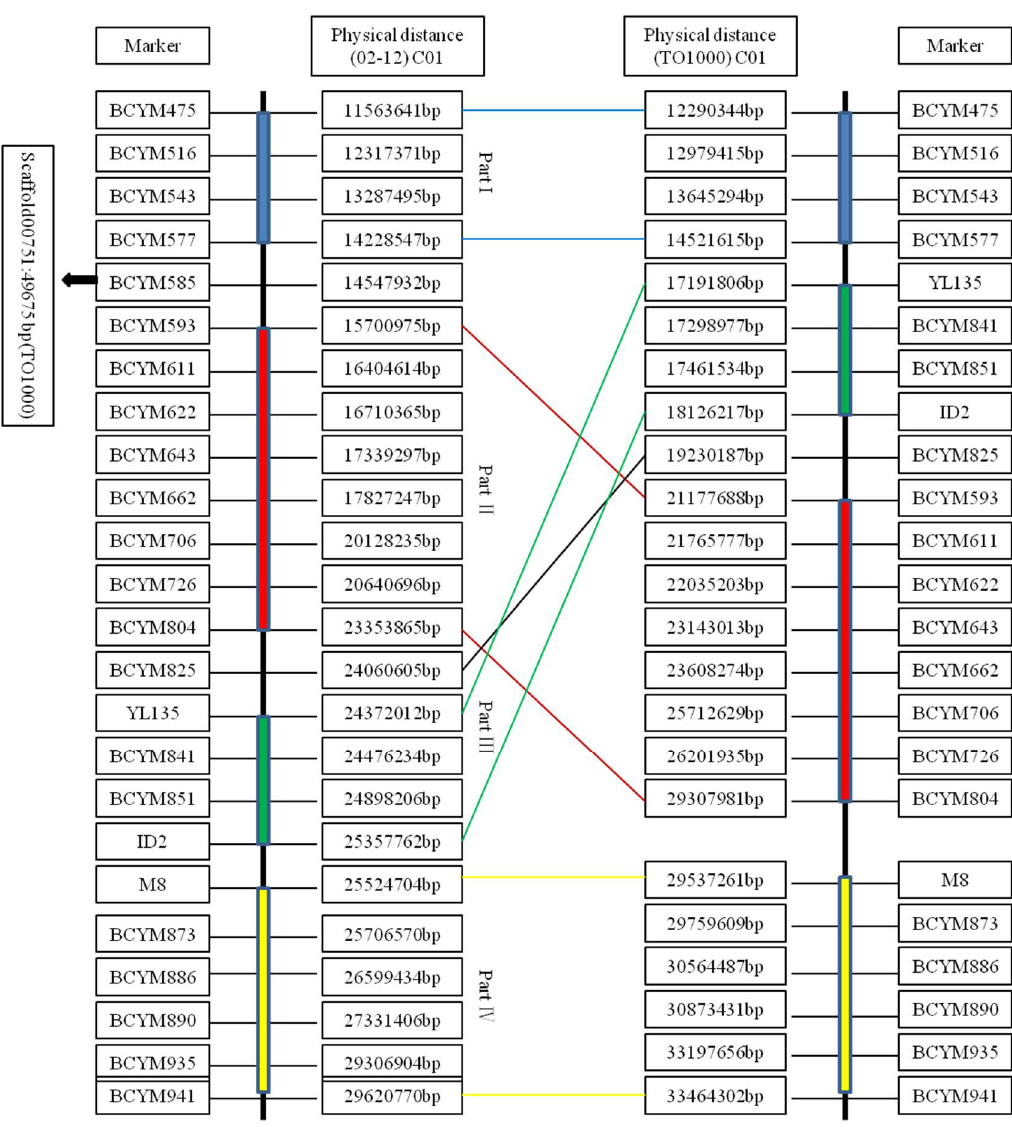
Figure 1. The physical distances of 24 InDel markers in the two reference genomes (02-12 and TO1000).